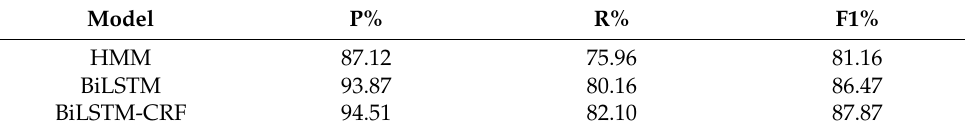
Table 6. Comparison of different entity recognition models in archaeological site text.